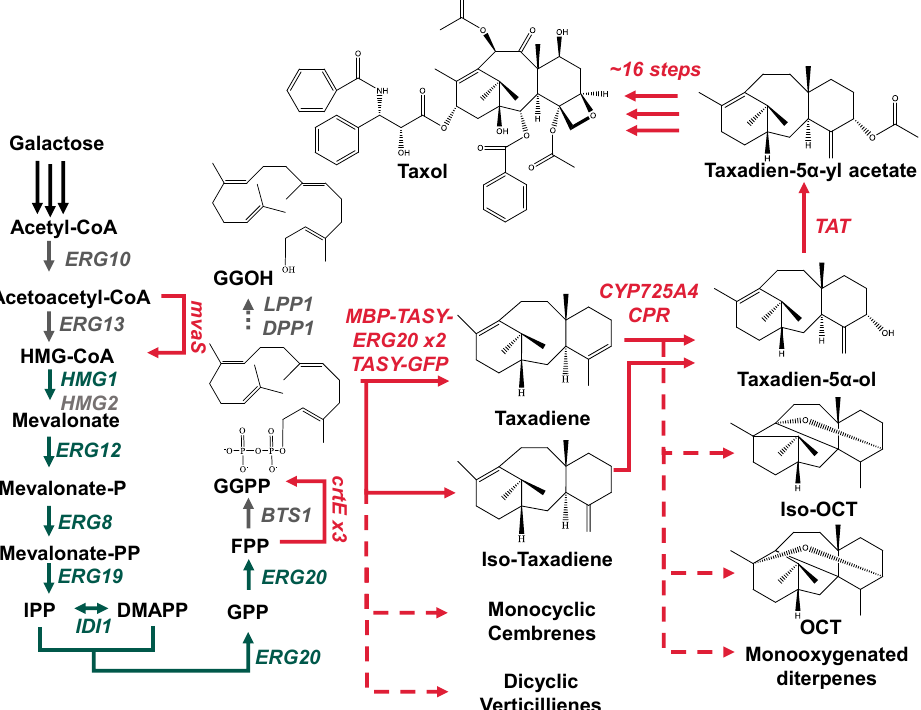
Figure 1. Engineered biosynthetic pathway in the Saccharomyces cerevisiae strain LRS6. Galactose is converted to the universal diterpenoid precursor, GGPP, via the mevalonate pathway. The first enzyme in the paclitaxel pathway, TASY, catalyzes the conversion of GGPP to taxadiene and small amounts of its isomer, iso-taxadiene. The second enzyme, CYP725A4, coupled with its cognate reductase subsequently catalyzes the oxidation of taxadiene to T5 α ol. The third enzyme, TAT, then catalyzes the acetylation of T5 α ol. The native, overexpressed genes are highlighted in green, whilst heterologous genes are highlighted in red. The dashed arrows highlight the undesirable side-products; the structures of the two well-characterized by-products, OCT and iso-OCT are